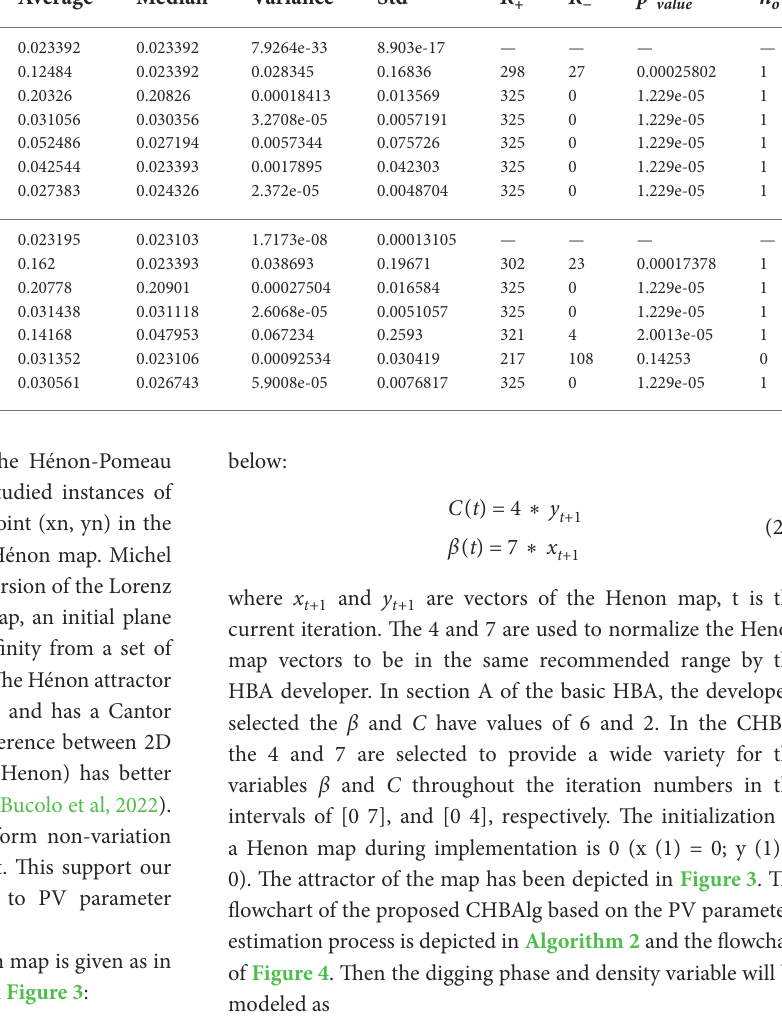
TABLE 6 StatisticalquantitiesforthefetchedresultsbyCHBAAlg,andotherconcurrentincaseofmodelingSDMandDDMmodelsoftheSLP080solar module. Statically metrics WSRT